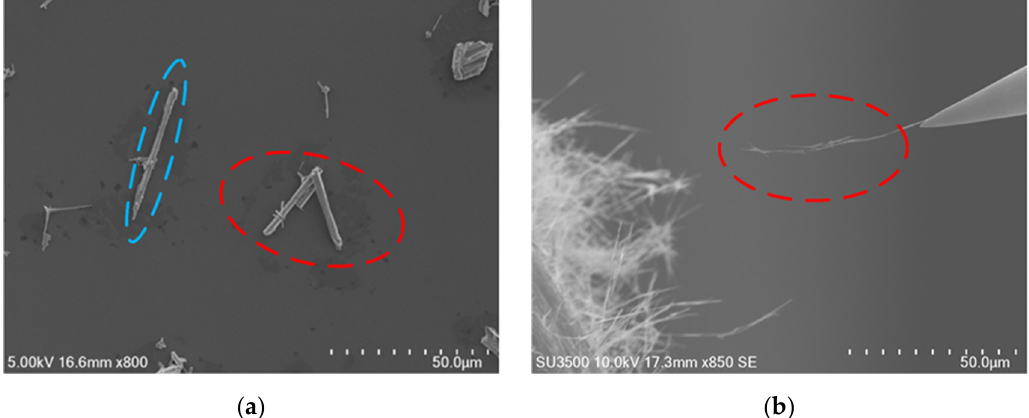
Figure 5. ZnO nanorods and ZnO nanowires. ( a ) ZnO nanorod marked by blue dotted line is suitable for operation and observation and marked by red dotted line means stacked ZnO nanorods. ( b ) ZnO nanowires marked by red dotted line are sample for piezoelectric properties characterization.